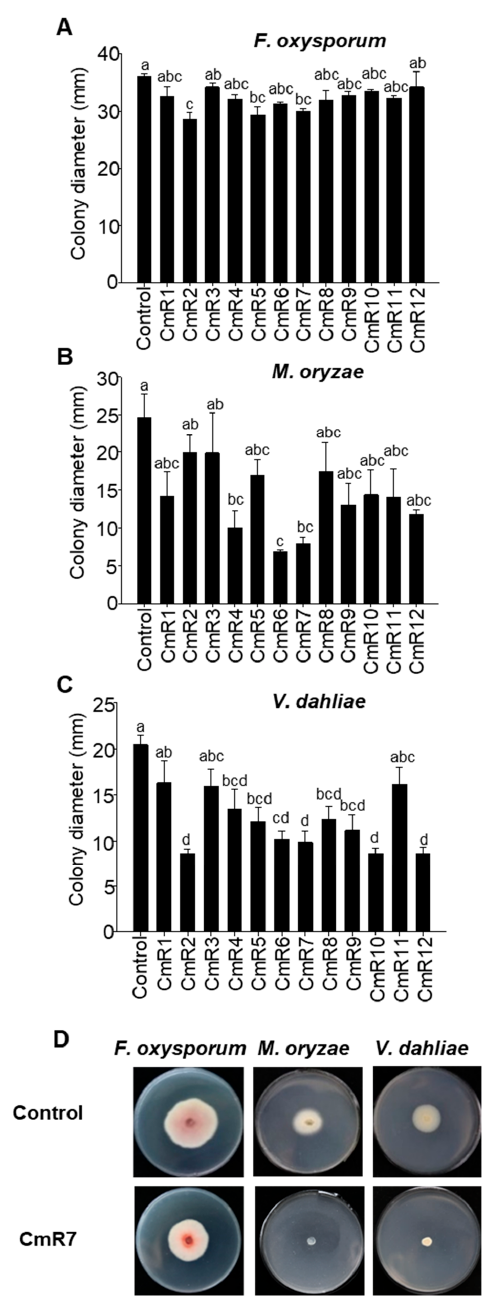
Figure 4. Effect of terpenoids from 12 cultivars of C. morifolium on the growth of three pathogenic fungi species: Fusarium oxysporum ( A ), Magnaporthe oryzae ( B ), and Verticillium dahliae ( C ). “Control” depicts a negative control with organic solvent ethyl acetate. ( D ) Representative growth of F. oxysporum , M. oryzae , and V. dahliae treated with a negative control (ethyl acetate) or with an extract made from CmR7 roots. CmR1-12 refer to the cultivar codes in Table 1. Different letters in ( A )–( C ) denote statistically significant differences among the means according to ANOVA analysis ( p < 0.05).